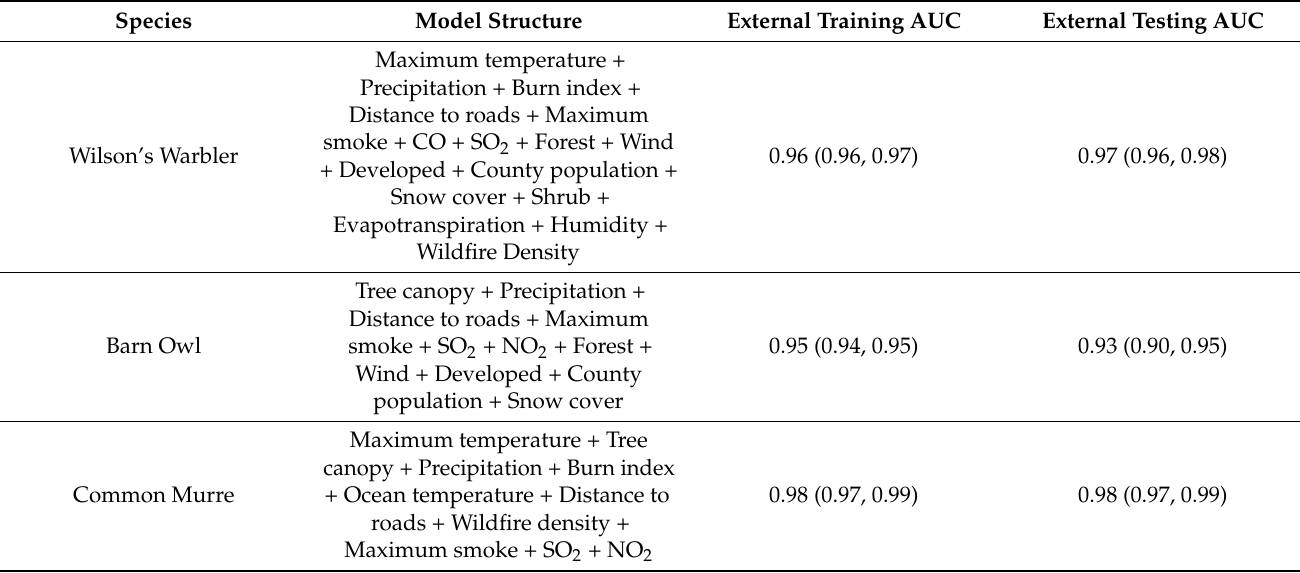
Table 2. Random forest model structure to describe the spatial distribution of the mortality of Wilson’s Warbler, Barn Owl, and Common Murre. For each model, we reported the AUC for external training and testing sets to assess model performance and predictive accuracy, respectively. We reported the 95 confidence intervals for the AUC values in parentheses. Model Structure External Training AUC External Testing